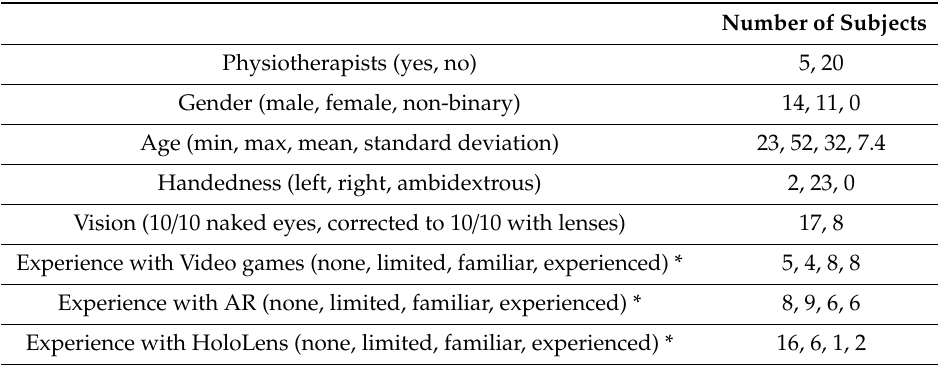
Table 2. Participant’s